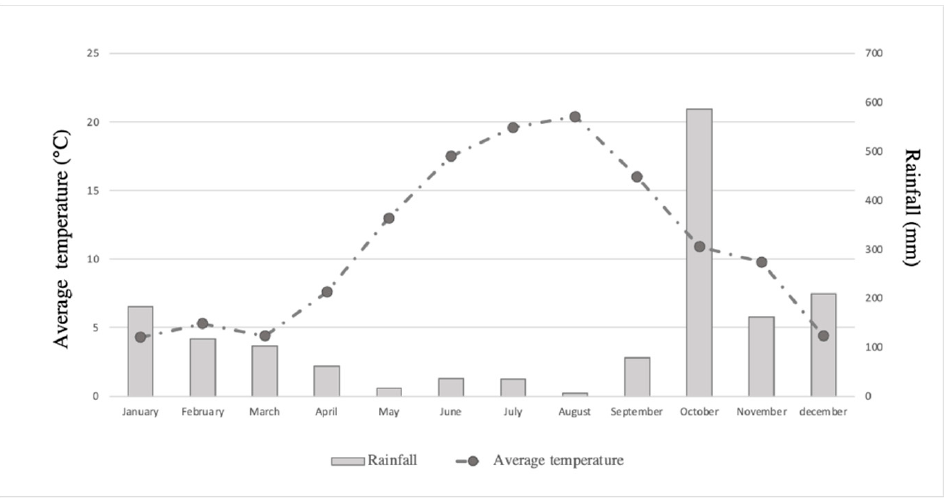
Figure 1. Total monthly rainfall and average monthly temperature recorded at Mongiana station (Vibo Valentia) in 2021